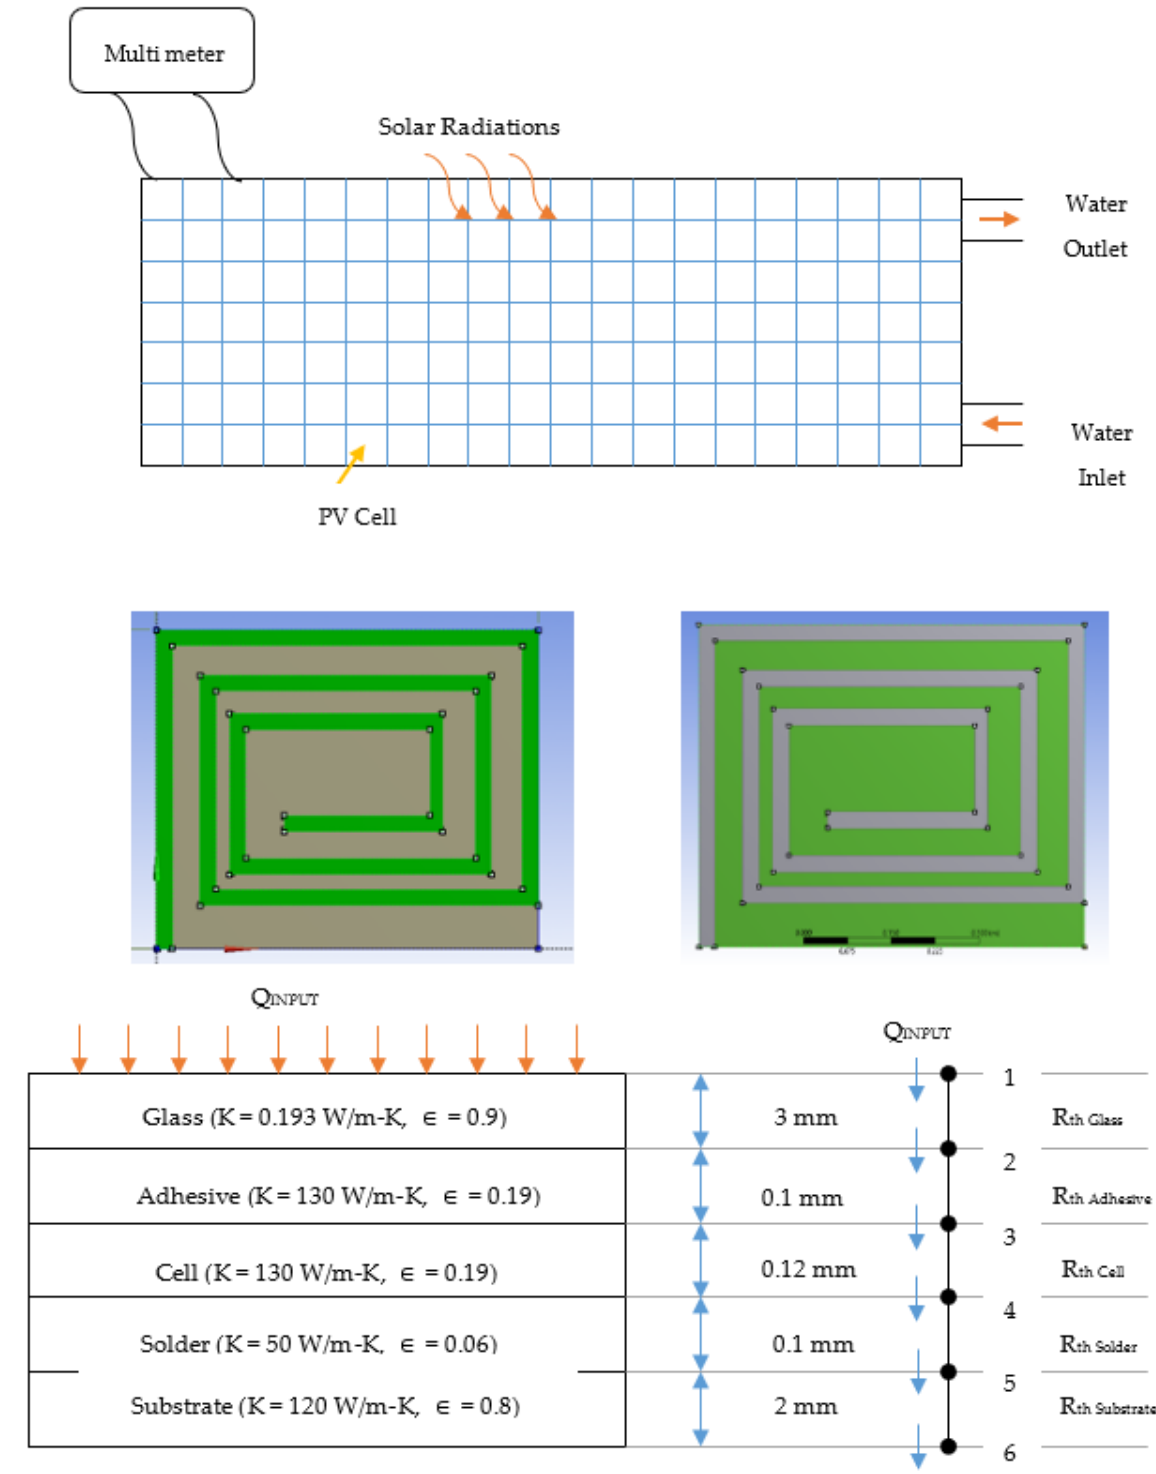
Figure 2. Top view of PV panel, back view of PV panel, and thermal resistance for individual com- ponent of PV cells. component of PV